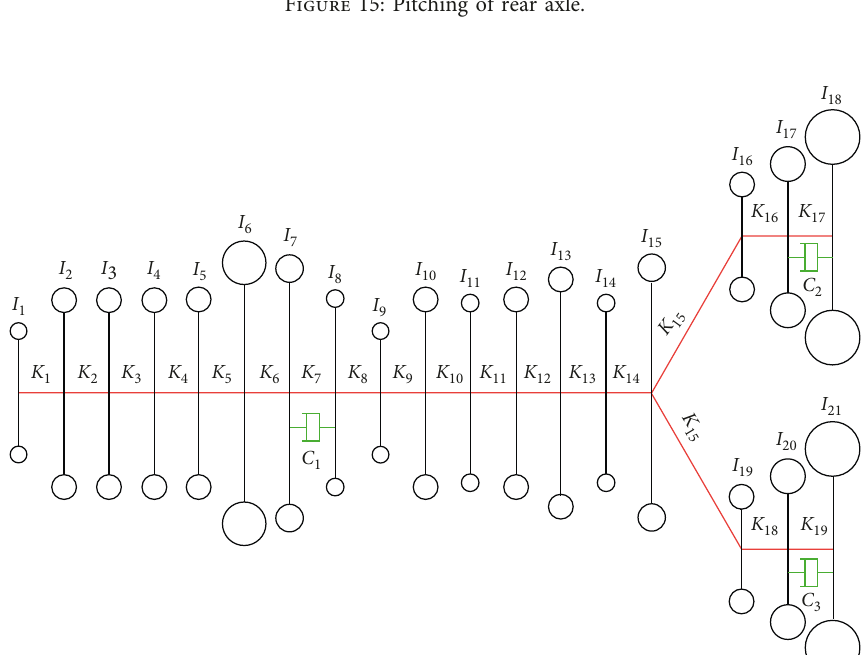
Figure 15: Pitching of rear axle.